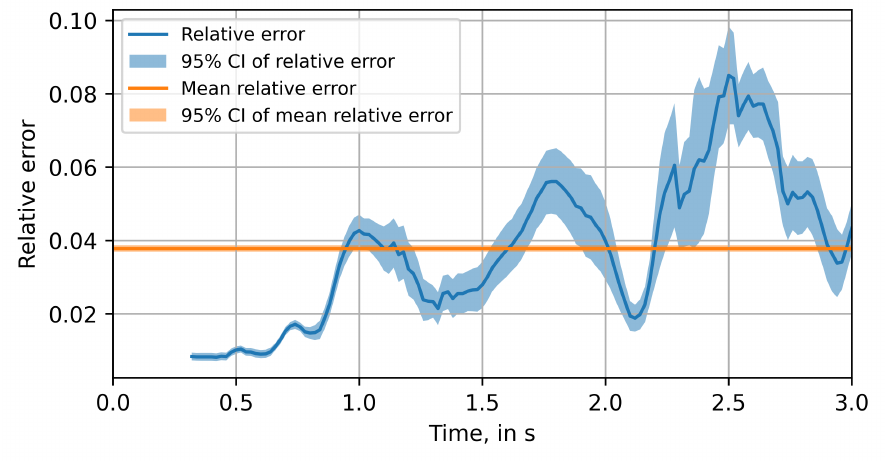
Figure 5. Free surface elevation relative error as a function of